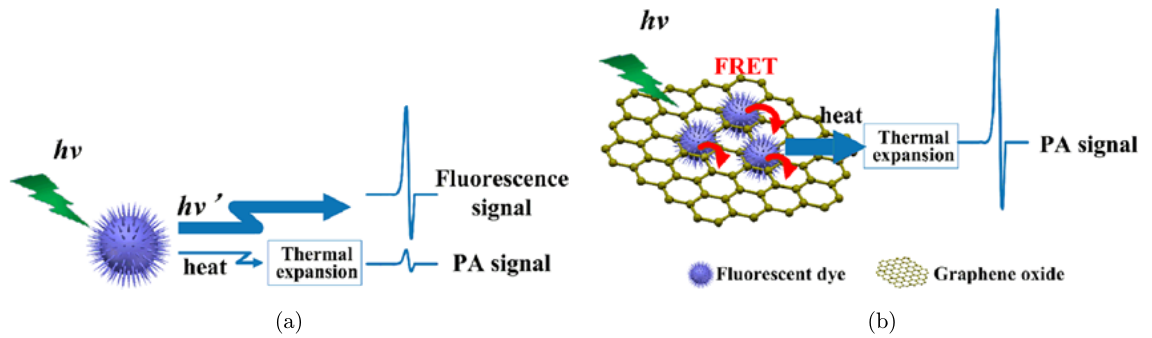
Fig. 5. (a) Fluorescent dyes with strong absorption, strong °uorescence and weak thermoelastic wave characteristics and (b) (cid:4) – (cid:4) stacking of dyes in close proximity to GO. GO quenches the dye °uorescence via FRET between dye molecules and GO. Using the pulse laser irradiation, the vast majority of absorbed light energy is converted to acoustic